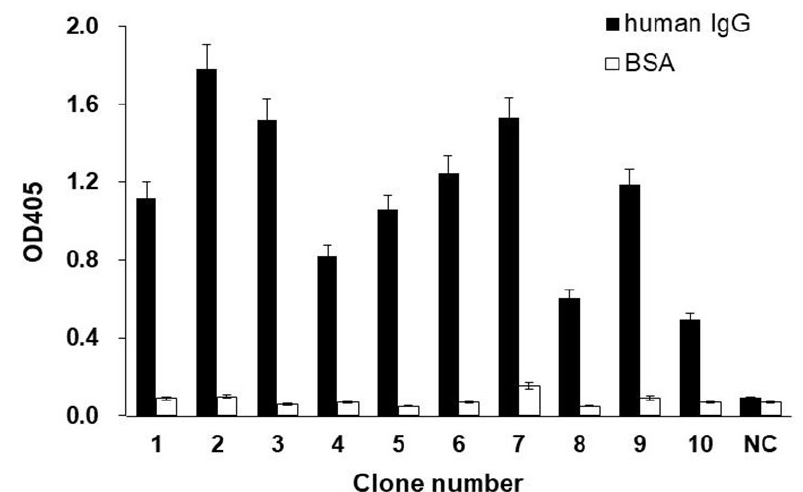
Figure 4. ELISA results showing the reactivity of culture supernatants from ten positive clones and one negative clone identified in Figure 3 against human IgG and bovine serum albumin (BSA; control). The negative clone (NC) was picked at random from colonies that showed no chemiluminescence signal. Data represent the mean of three replicates; error bars represent the standard deviation.